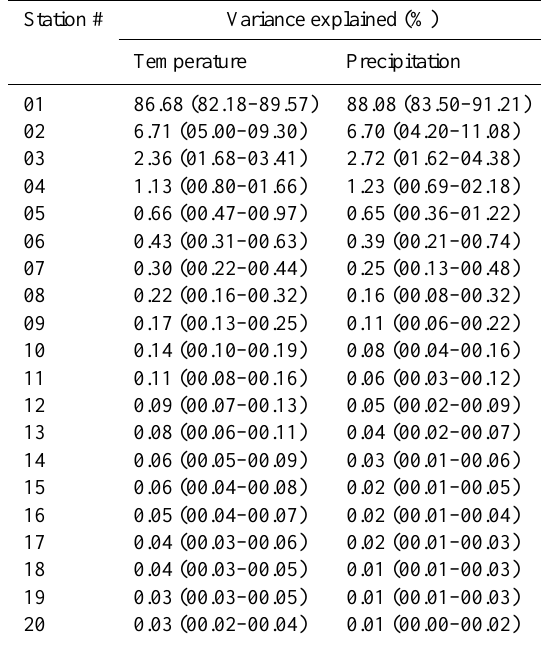
Table 3. Percent of the variance explained with each station selec- tion. Values shown are the median and 5th–95th percentile values (in parentheses) based on all 50000 Monte Carlo